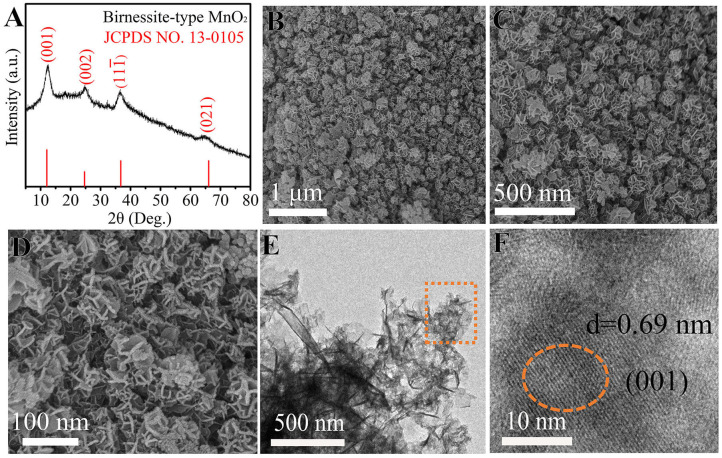
(A) XRD pattern, (B–D) SEM images, and (E,F) TEM images of δ-MnO2.